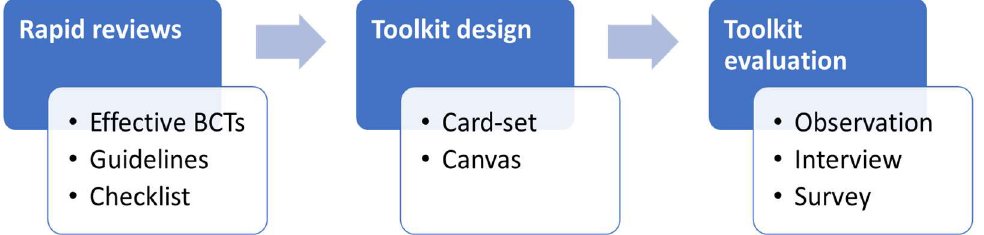
Figure 1. Overview of the study flow.